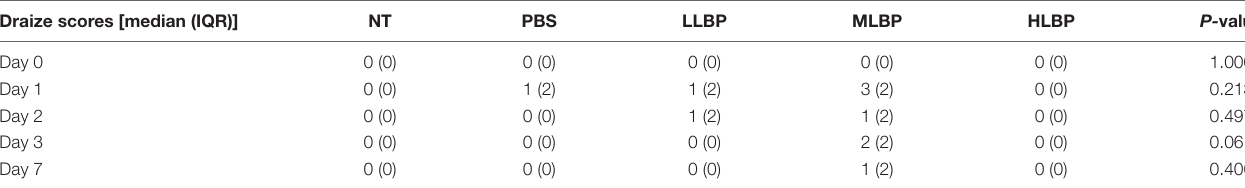
TABLE 2 | The comprehensive results of ocular surface irritation scored following the Draize scale scoring system. Draize scores [median (IQR)]